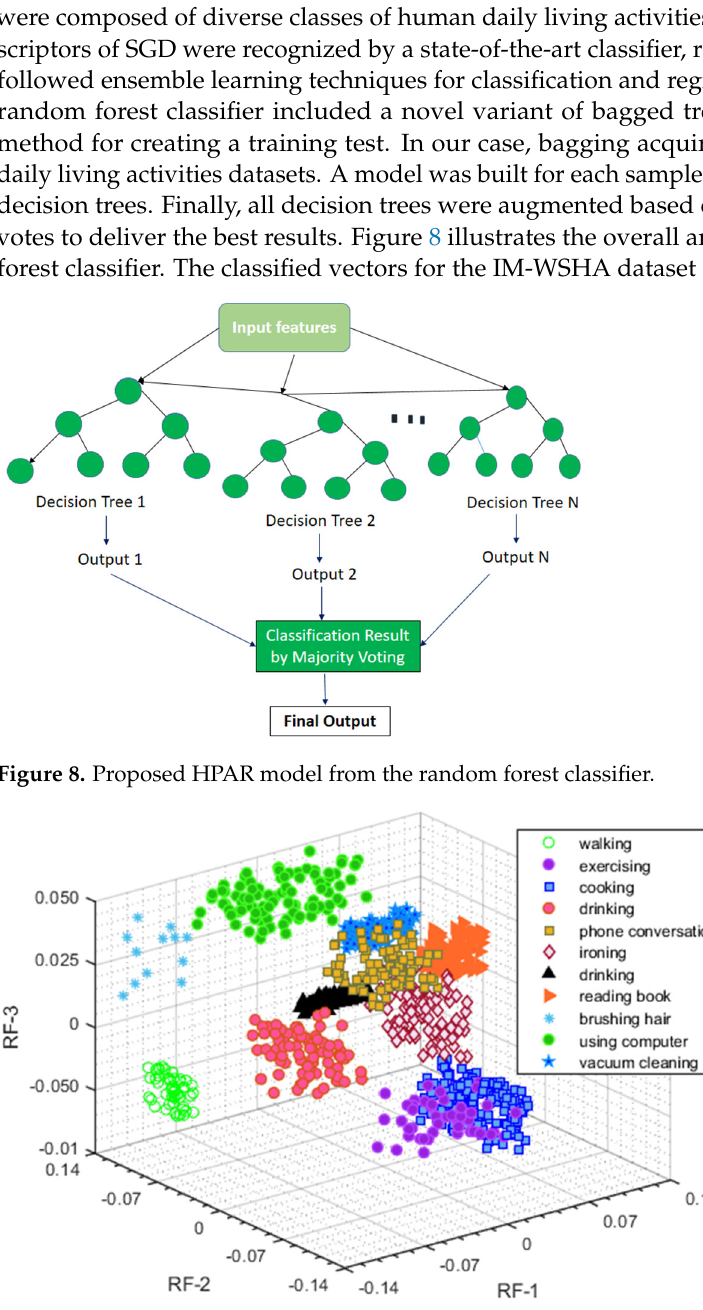
Figure 9. Random forest recognition on the IM − WSHA benchmark dataset.